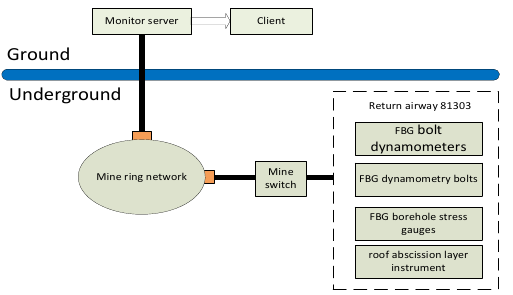
Figure 5. Data transmission schematic diagram of the FBG dynamometry bolt.